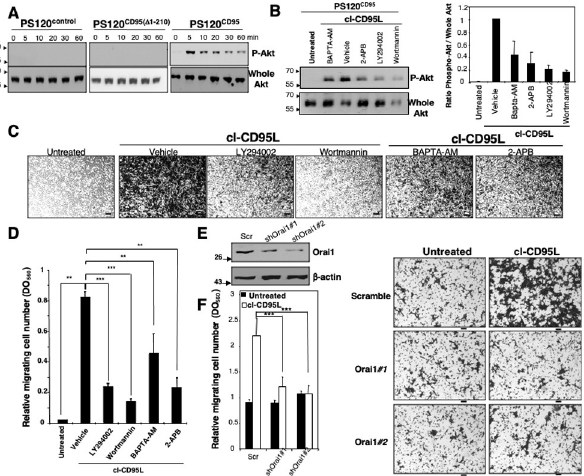
Fig 4. cl-CD95L promotes a cell migration through a Ca 2+ /PI3K/Akt signal. (A) The CD95-deficient fibroblastic cell line PS120 transfected with empty vector (wild type NHE1-reconstituted PS120 control ) or reconstituted with either human wild type CD95 (PS120 CD95 ) or a death domain-truncated CD95 (PS120 CD95( Δ 1–210) ) was incubated with 100 ng/ml of cleaved CD95L for indicated times. Cells were harvested, lyzed, and 100 μ g of protein was loaded per lane. Proteins were resolved in a SDS-PAGE and immunoblots were performed. Phosphorylation of the serine 473 on Akt indicates activation of the kinase. Whole Akt is added as loading control. The PS120 immunoblots shown in (A) have been partly reused in [3]. (B) Left panels : PS120 CD95 cells were pre-incubated with non-cytotoxic and non-cytostatic concentration of PI3K inhibitors (2.5 μ M of wortmannin and 5 μ M of LY294002), the cell permeant chelator of calcium BAPTA-AM (5 μ M), the inhibitor of IP3-R and SOC channels 2-APB (20 μ M) or DMSO (vehicle). Cells were then untreated (control medium from pcDNA3.1(+)-transfected HEK cells) or treated for 5 min with 100 ng/ml of cl- CD95L and lysed, 50 μ g/ml of protein was loaded per lane and indicated immunoblots were performed. Right panel : the densitometry analyses of the immunoblot bands were performed using ImageJ software and the histograms depict Phospho-Akt/whole Akt ratios. (C) Cell migration of PS120 CD95 was assessed using the Boyden chamber assay. Cells were pre-incubated with non-cytotoxic and non-cytostatic concentrations of PI3K inhibitors (2.5 μ M of Wortmannin and 5 μ M of LY294002), the cell permeant chelator of calcium BAPTA-AM (5 μ M), the inhibitor of SOC channels 2-APB (20 μ M) or DMSO (vehicle) for 30 min and then stimulated with 100 ng/ml of cl-CD95L or a control medium (supernatant from pcDNA3.1(+)-transfected HEK cell—untreated) for 24 h. For each experiment, 10 pictures of the migrating cells were taken, and a representative picture was depicted (Bars = 50 μ m). (D) Cells were treated as described in (C). To quantitatively measure cell motility, Giemsa-stained migrating cells from the lower side of the membrane were lyzed, and absorbance was measured at a wavelength of 560 nm. Values represent means and SD of three independently performed experiments. �� p � 0.01 and ��� p � 0.001 as calculated using two-tailed non-parametric Mann-Whitney test. (E) The silencing effect of the Orai1-targeting shRNAmir-pGIPZ vectors was analyzed by immunoblot in lentiviral-transduced HEK cells. 48 h after transduction, cells were lysed and 100 mg of lysates were loaded per line. β -actin serves as a loading control. (F) Cell migration of indicated shRNAmir-transduced HEK cells was assessed using Boyden chamber assay. Right panels : HEK cells were transduced with scrambled or Orai1-targeting ShRNA, and 48 h later, cells were incubated for 24 h in the presence of 100 ng/ml of cl-CD95L or untreated (supernatant of pcDNA3.1(+)-transfected HEK cells). Migrating cells were fixed with methanol and stained by Giemsa. For each experiment, five pictures of random fields were taken, and a representative picture was depicted (Bars = 70 mm). Left panel : To quantitatively measure cell motility, Giemsa-stained migrating cells from the lower side of the membrane were lyzed, and absorbance was measured at a wavelength of 560 nm. Values represent means and SD of three independently performed experiments. ��� p � 0.001 as calculated using two-tailed non-parametric Mann- Whitney